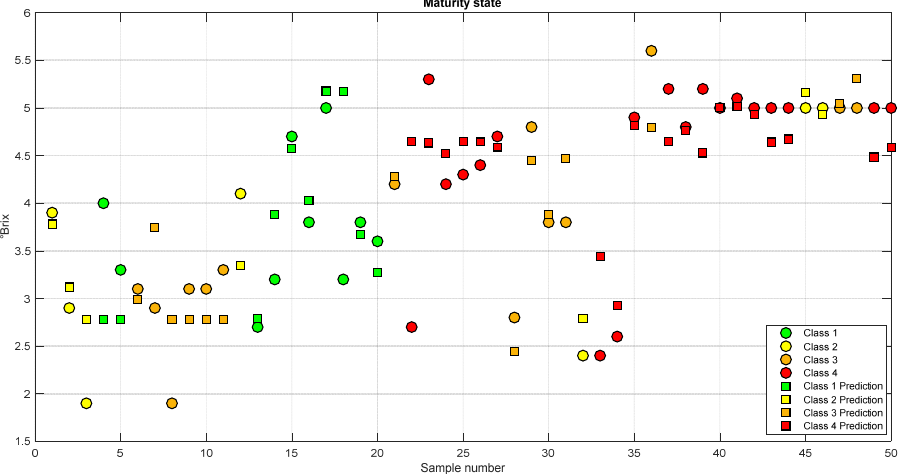
Figure 18. The samples ° Brix was measured with refractometry. The measurements are presented as circles and the proposed system’s estimates are indicated by squares.